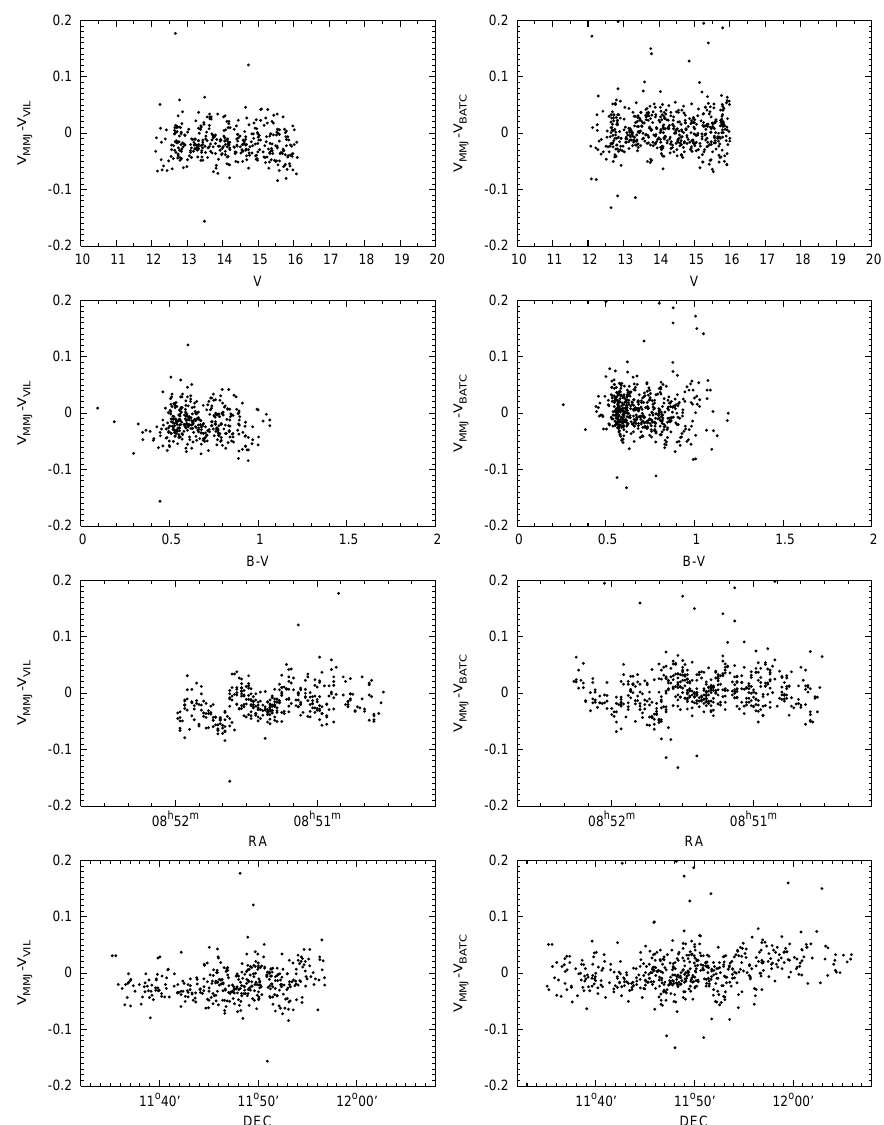
Fig. 3. Differences between V MMJ and V VIL (left panels), and V MMJ and V BATC magnitudes (right panels). This comparison reveals in MMJ photometry 5–6% large-scale systematic errors along